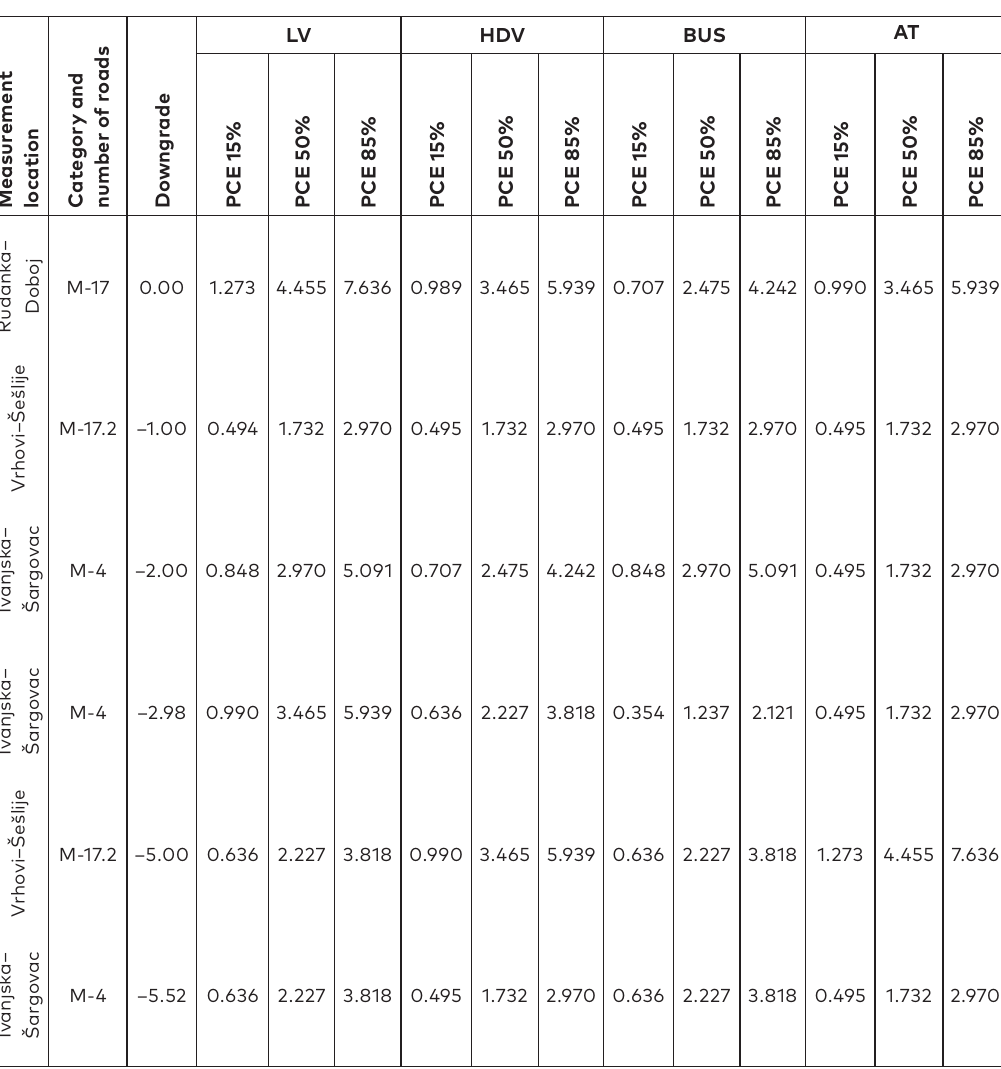
Table 6. Comparison of PCE 15%, PCE 50% and PCE 85% values by vehicle